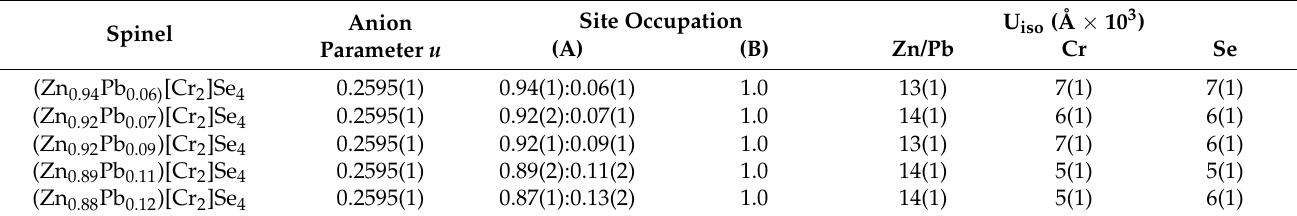
Figure 4. ( a ) A part of quartz ampoule with obtained ZnCr 2 Se 4 :Pb single crystals. Examples of sin- gle crystals obtained in the ZnCr 2 Se 4 :Pb system: ( b ) Zn 0.94 Pb 0.06 Cr 2 Se 4 , ( c ) Zn 0.92 Pb 0.09 Cr 2 Se 4 , ( d ) Zn 0.88 Pb 0.12 Cr 2 Se 4. Table 3. Atomic coordinates and equivalent isotropic displacement parameters of the Zn 1 − x Pb x Cr 2 Se 4 single crystals. The Wyckoff positions of the atoms in the spinel structure are: Zn in 8 b (3/8, 3/8, 3/8); Cr/Ta in 16 c (